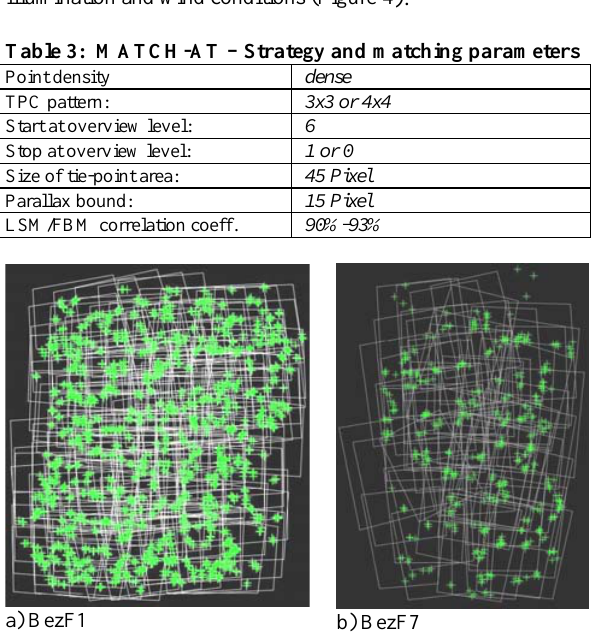
Figure 2: Flight BezF1 area.